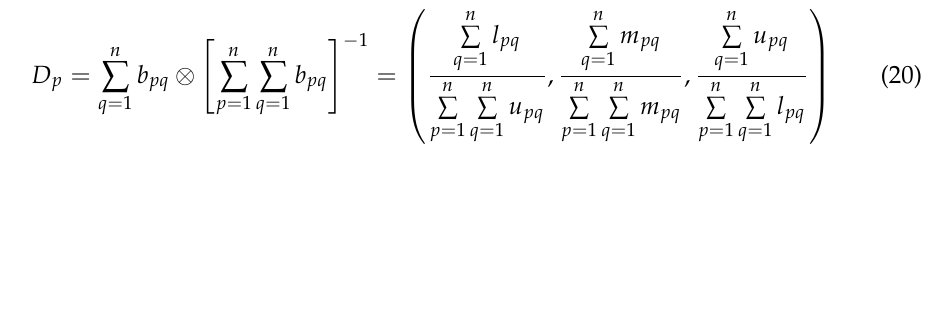
Table 3. The 1–9 scale method.